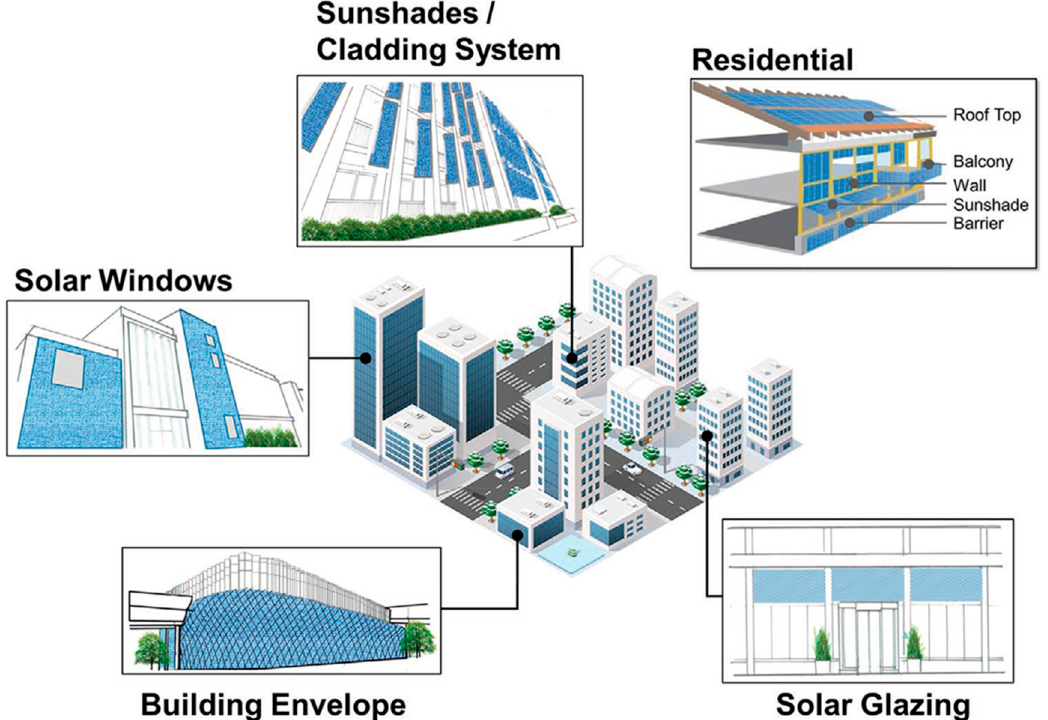
Figure 8. Application of BIPV into various surfaces of buildings unravelling the potential of solar energy for on-site energy production. Reprinted with permission from Ref. [158].